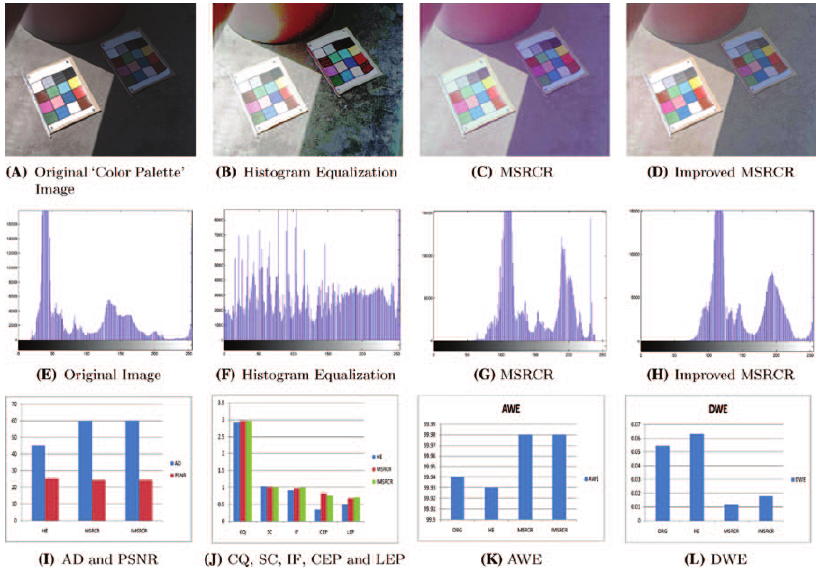
Figure 13. (Top) Image Enhancement Methods. (Middle) Histogram Plots: x -axis, Intensity Levels Ranging from 0 to 255; y -axis, Total Number of Pixels. (Bottom) Conventional Metrics and Proposed AWE and DWE Metrics. The “Color Palette” Image has been Downloaded from http://ivrg.epfl.ch/page-74617-en.html.